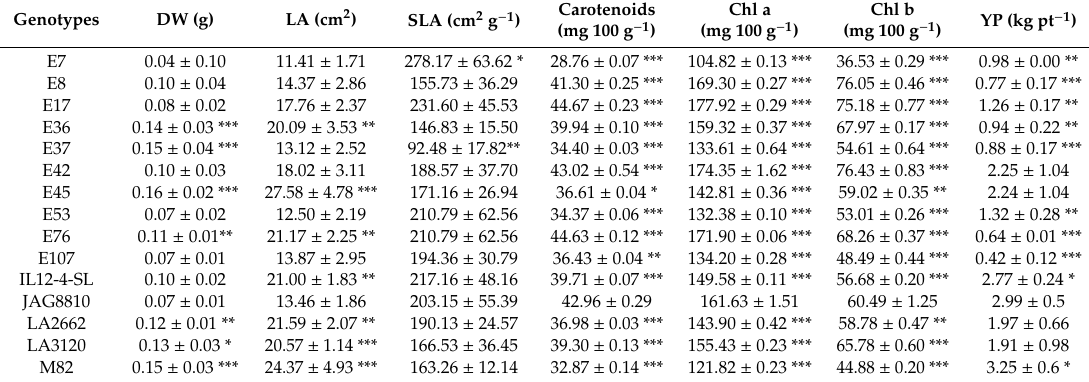
Table 1. Leaf traits (DW = dry weight of individual leaves, LA = leaf area, SLA = specific leaf area), total carotenoids, chlorophylls (Chl a and Chl b) and crop yield per plant (YP) evaluated on tomato genotypes grown under a plastic walk-in tunnel. Values are means ± standard deviation. ANOVA with Least Significant Di ff erence (LSD) post-hoc test was used to compare each genotype vs. the control genotype JAG8810. The asterisks indicate statistically significant di ff erences at * p < 0.05; ** p < 0.01; *** p <